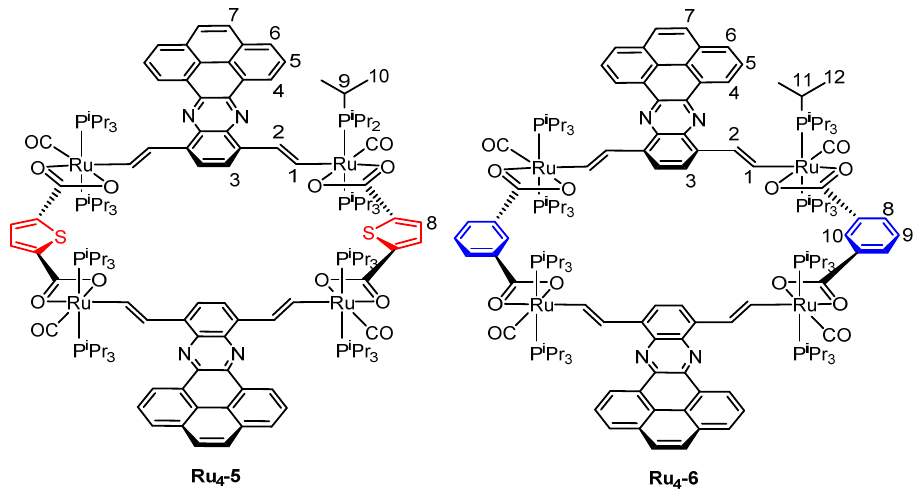
Figure 10. Atomic numbering for NMR characterization.